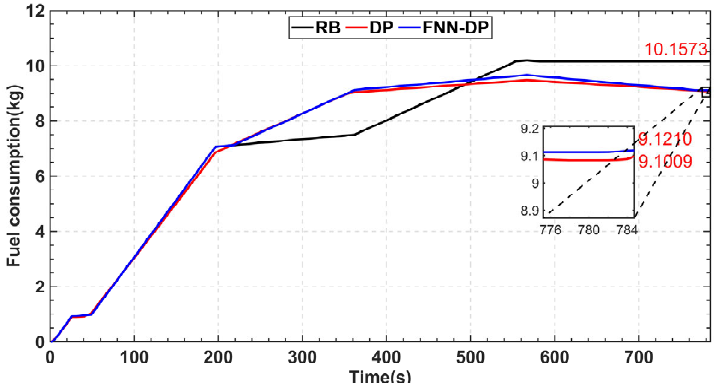
Figure 17. Comparison of fuel consumption between RB strategy, DP strategy and FNN ‐ DP.